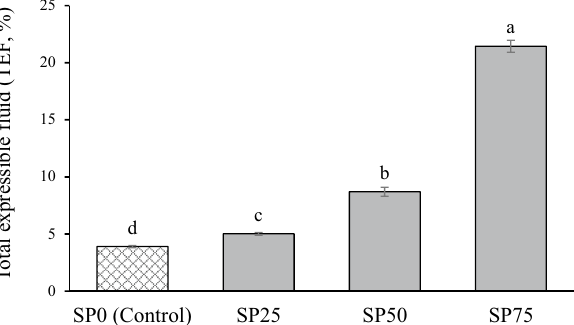
Figure 3. Total expressible fluid (TEF, %) of silkworm pupae-fortified chicken bread spread at different levels. SP0 (Control): Chicken bread spread without fortification with silkworm pupae. SP25, SP50, and SP75: Silkworm pupae-fortified chicken bread spread with the replacement of chicken meat at 25, 50, and 75%, respectively. Different letters on the bars indicate significant differences ( p ≤ 0.05).